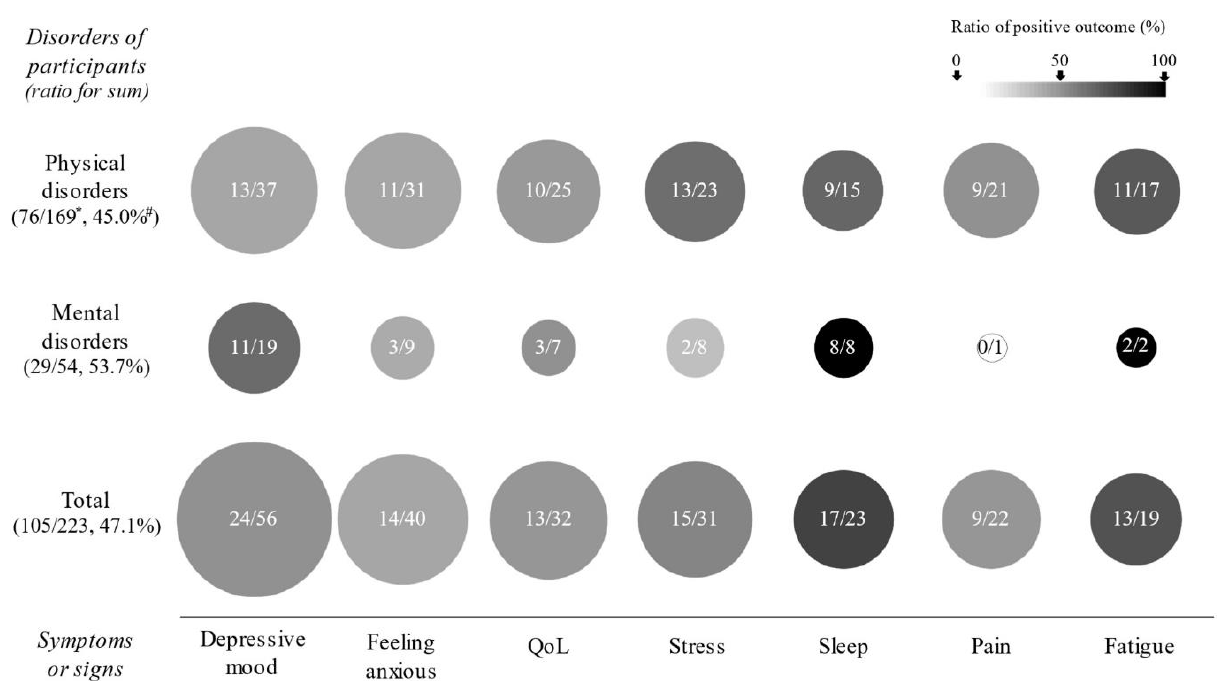
Figure 3. The features of significant outcomes in the RCTs according to physical and mental disorders. Regarding all measurements, the seven most frequently assessed outcomes are displayed according to subjects with physical and mental disorders. The circle’s size and level of darkness indicate the number of RCTs and the ratio of positive outcomes, respectively. The positive outcome indicates that the treatment achieved statistical significance compared to the control ( p < 0.05 or Cohen’s d > 0.5). */# indicates the total number of outcomes measured for the seven symptoms in the RCTs for patients with given disorders and positive outcomes and their ratios.